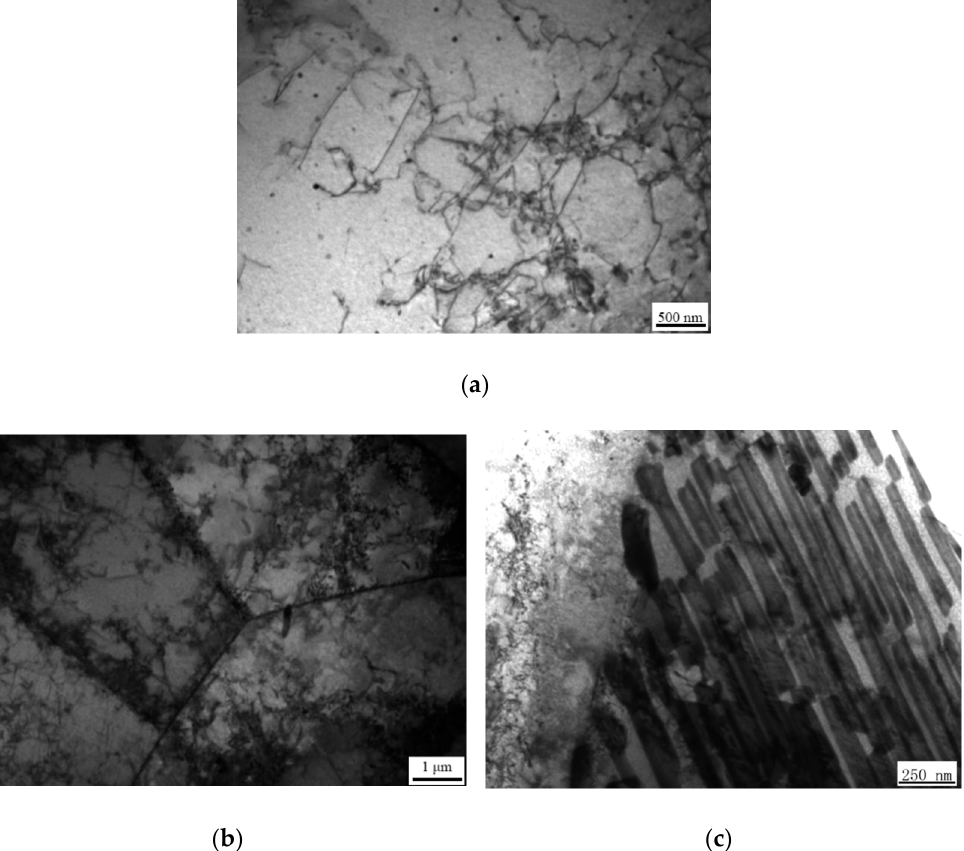
Figure 6. TEM image of the worn edge, ( a ) the original sample; ( b ) ferrite, ( c ) pearlite.